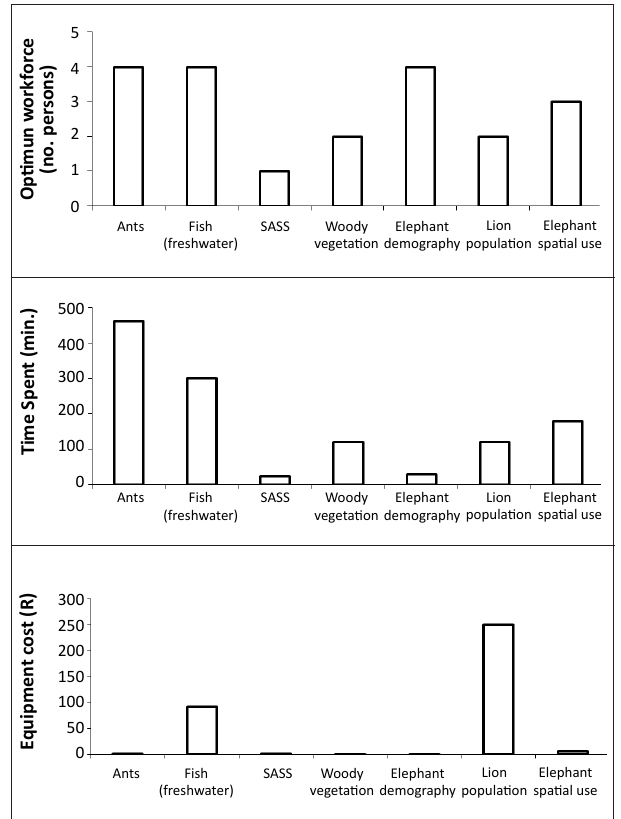
FIGURE 2: Estimated total resource costs per unit sampling area of the ant monitoring project in the Kruger National Park compared with six other monitoring projects in SANParks (different area for each project, but the minimum relevant unit area is used in each